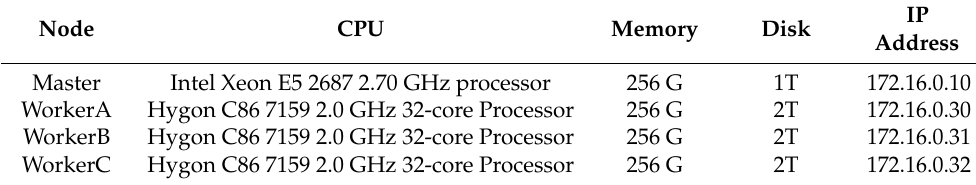
Table 1. Devices configuration settings.